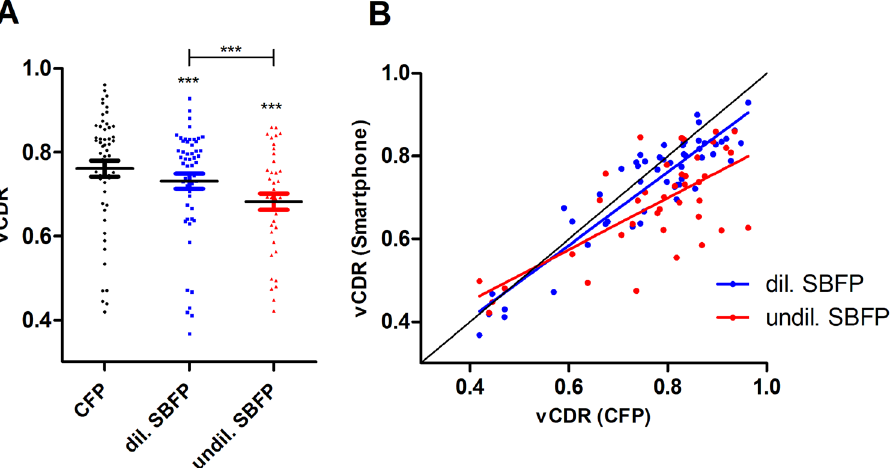
Figure 6. Evaluation of vertical Cup-to-disc ratio. Conventional fundus photography (CFP) and dilated (dil.) and undilated (undil.) smartphone-based fundus photography (SBFP) were compared. ( A ) Comparison of the individual devices and ( B ) correlation of vertical Cup-to-disc ratio (vCDR) measurement on dil. and undil. SBFP with vCDR-measurement on CFP. Error bars indicate standard error of the mean, paired t-test was used for analysis, asterisks indicate significant differences in regards to CFP if not otherwise indicated, *** p <